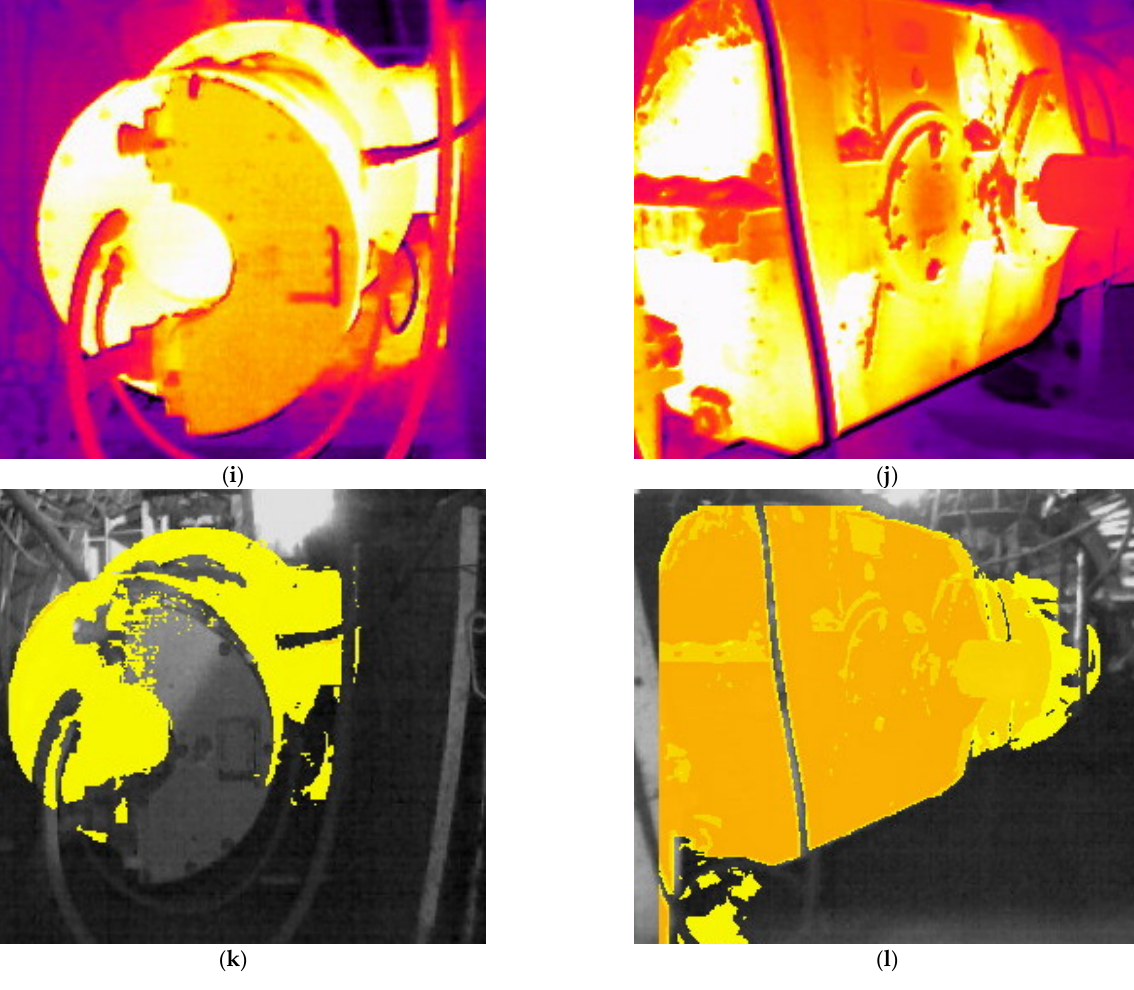
Figure 7. A view from a measurement session made with a thermal imaging camera together with processing in the software FLIR Tools for (I) a drive unit of a belt conveyor PT-4 from the main haulage analysed, where the heat distribution is presented for: ( a ) photo of the tested left gearbox (I); ( b ) thermogram with visible thermal effect for the left gearbox (I); ( c , d ) thermogram showing heat distribution for the left gearbox (I); ( e ) photo of the tested left motor (I); ( f ) thermogram showing heat distribution for the left motor (I); ( g , h ) thermogram showing the thermal effect for the left motor (I); ( i , j ) thermogram showing the heat distribution with the Dräger UFC 9000 camera; ( k ) temperature distribution for the motor in the excavation environment; ( l ) temperature distribution for the gearbox in the excavation environment.